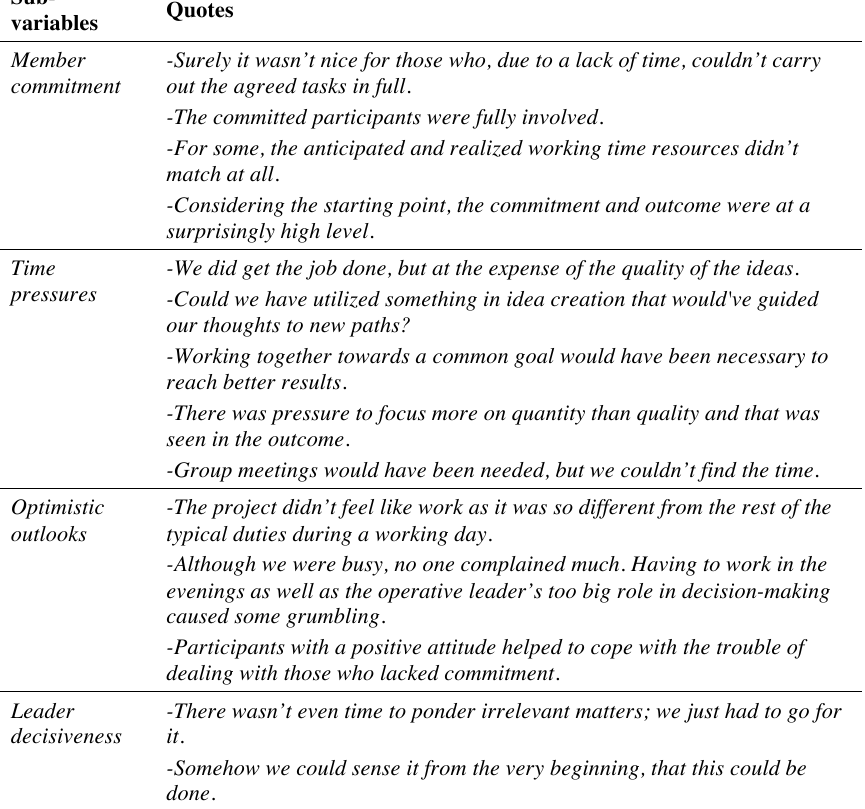
Table 3. Quotes related to project